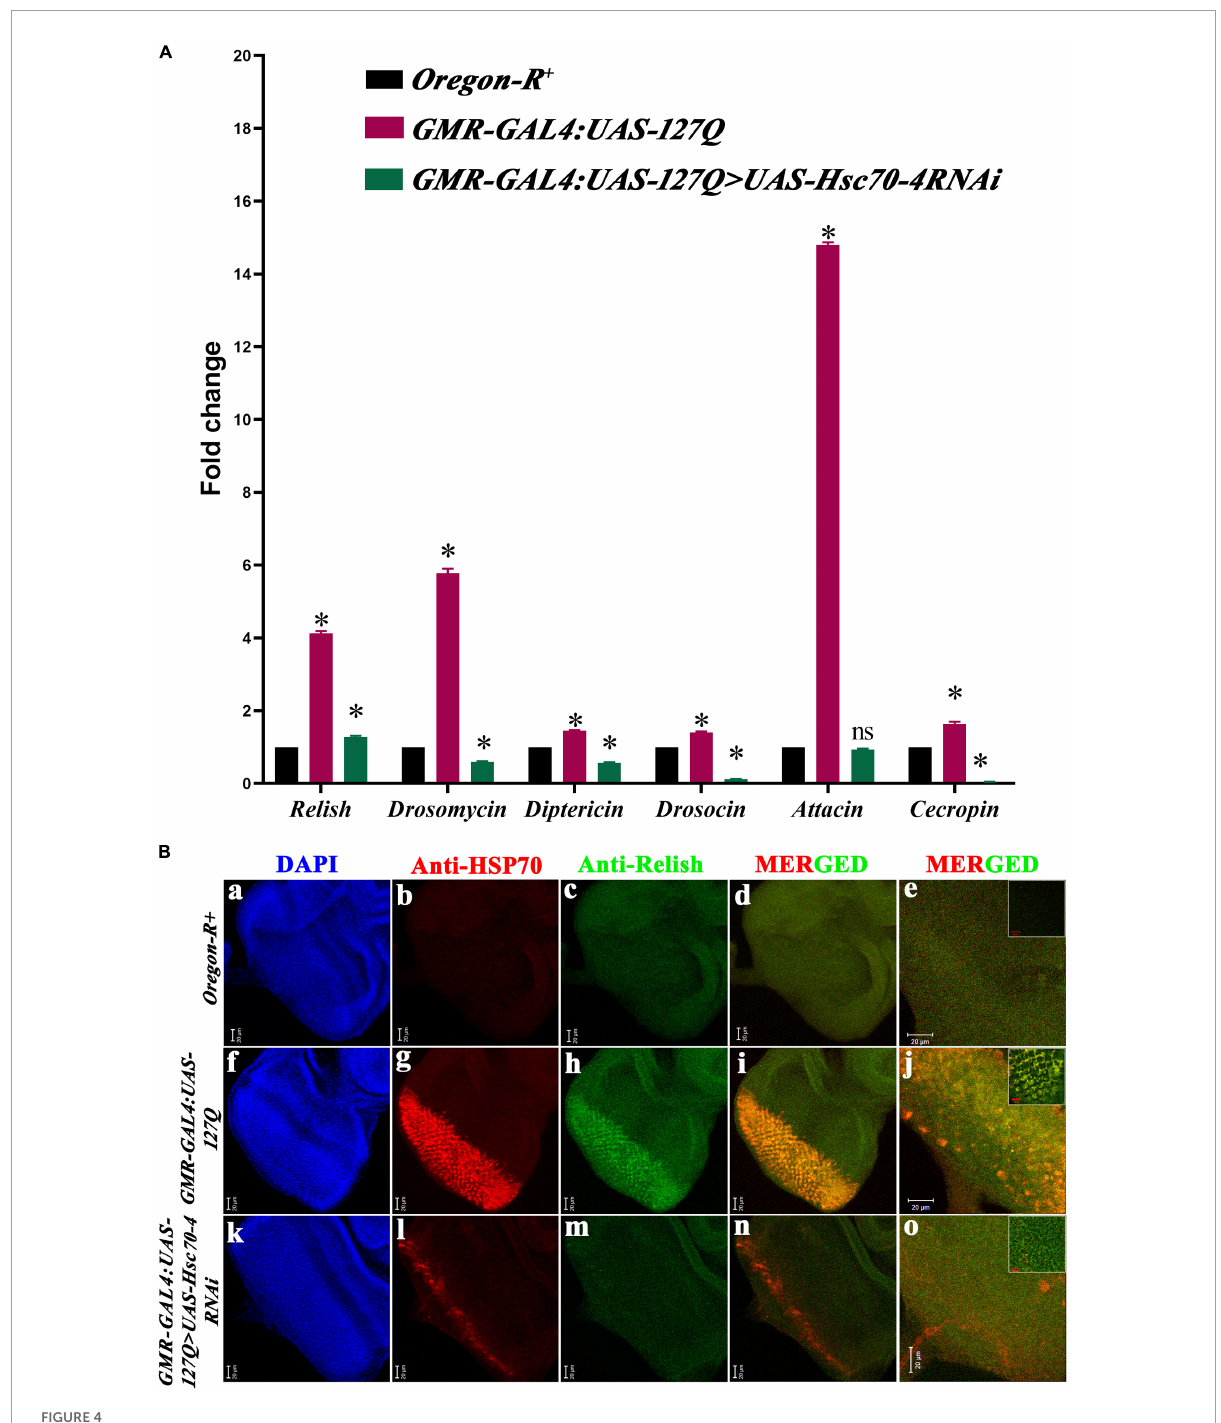
FIGURE4 Elevated immune responses in the polyQ background get reduced upon hsc70-4 downregulation. (A) The histogram shows qPCR analysis representing the fold change in transcript level of relish and AMPs in GMR-GAL4:UAS-127Q conditions significantly elevated in comparison to the wild-type. But GMR-GAL4:UAS-127Q > UAS-Hsc70-4RNAi shows a significant decline in these respective immune genes (data normalized to rp49 , three biological replicated were used, and data are shown as ± SEM; ns means insignificant change at p -value of ≤ 0.05, and ∗ indicated significance at the p -value of ≤ 0.05). (B) Reduction in expression of Relish (green) and HSP70 (red) after downregulation of hsc70-4 in GMR-GAL4:UAS-127Q > UAS-Hsc70-4RNAi in comparison to GMR-GAL4:UAS-127Q , in lower magnification (a–d,f–i,k–n) and (e,j,o) shows the higher magnification (scale bar 20 µ m). The inset in (e,j,o) was captured at a further 3X zoom to show co-localization (scale bar 10 µ m). Genotype description, Oregon-R + (a–e) ; GMR-GAL4:UAS-127Q (f–j) ; GMR-GAL4:UAS-127Q > UAS-Hsc70-4RNAi (k–o)